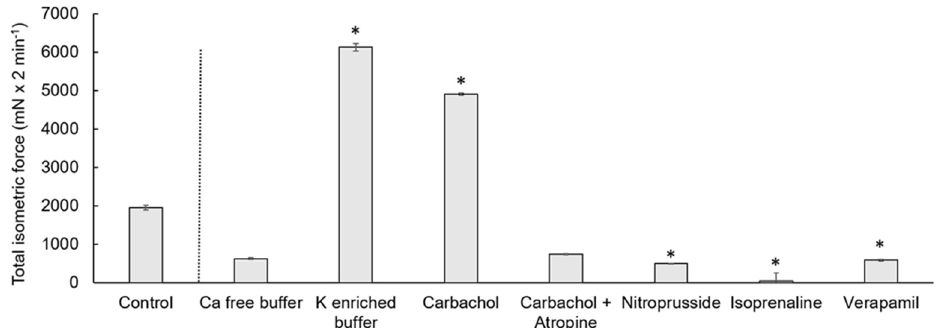
Figure 4. Total isometric force measured as the AUC of cecal circular smooth muscle contraction. The control condition and